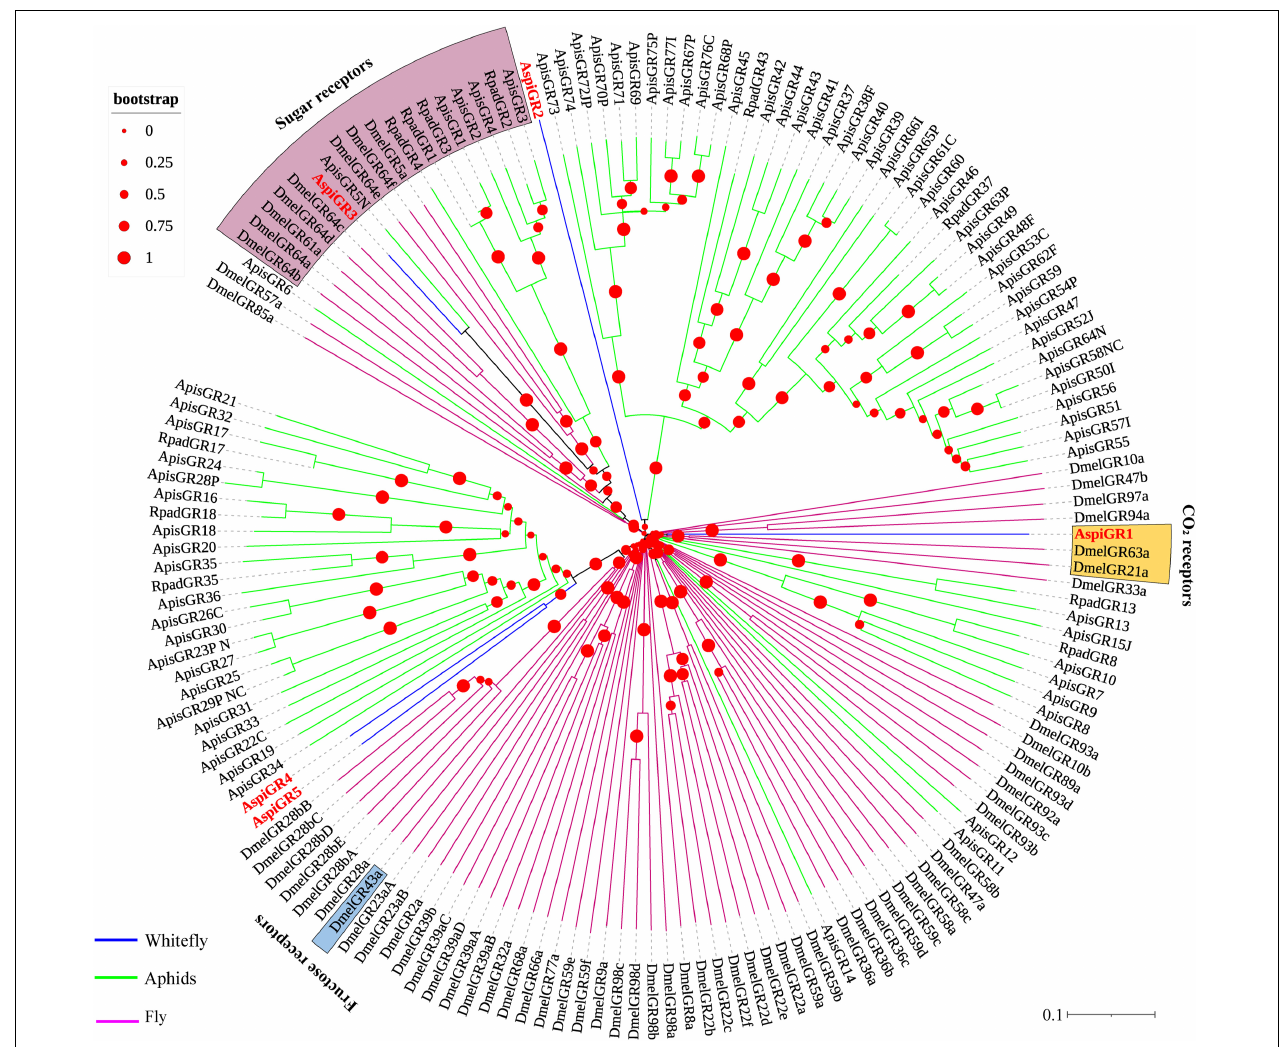
FIGURE 6 | Phylogenetic analysis of putative gustatory receptors (GRs) of A. spiniferus . The phylogenetic tree was built using GR sequences from whitefly specie (Aspi, A. spiniferus ), aphid species (Apis, A. pisum ; Rpad, R. padi ; Agos, A. gossypii ) and fly ( Drosophila melanogaster